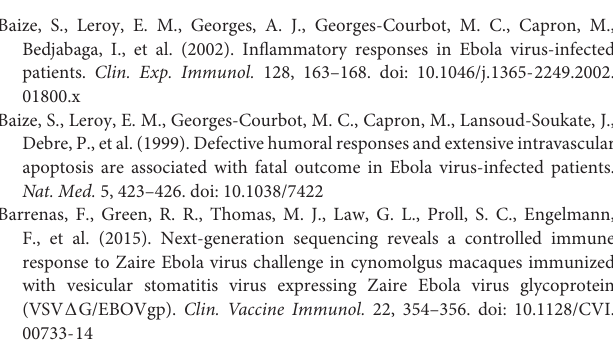
Supplementary Figure 3 | Ebola virus infection results in lymphopenia, neutrophilia, and thrombocytopenia. (A) Total number of white blood cells (thousand/ µ l), (B) lymphocytes (% total cells), (C) neutrophils (%) total cells, and (D) platelet count (thousand/ µ l) for EBOV-Mayinga and EBOV-Makona isolates